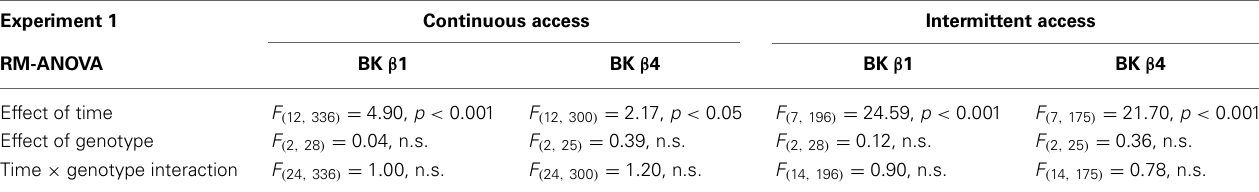
Table 1 | Statistical analysis of the effects of time and genotype on ethanol intake in Experiment